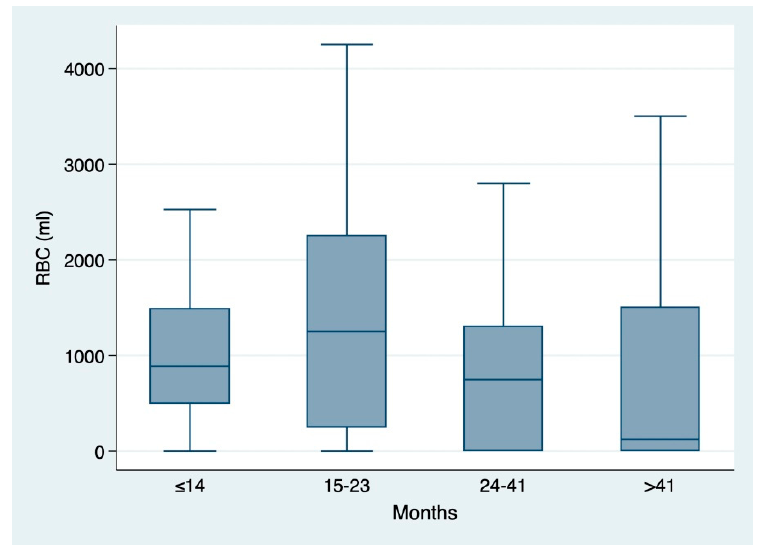
Figure 1. Box and whiskers plot showing the distribution of red blood counts (RBC, mL) according to the time between hepatic resection and secondary liver transplantation (time HR-SLT): ≤ 14 mo. (median 1000 mL, IQR 500–2250); 15–23 mo. (1250 mL, IQR 250–2500); 24–41 mo. (750 mL, IQR 0–1600); >41 (350 mL, IQR 0–1750).